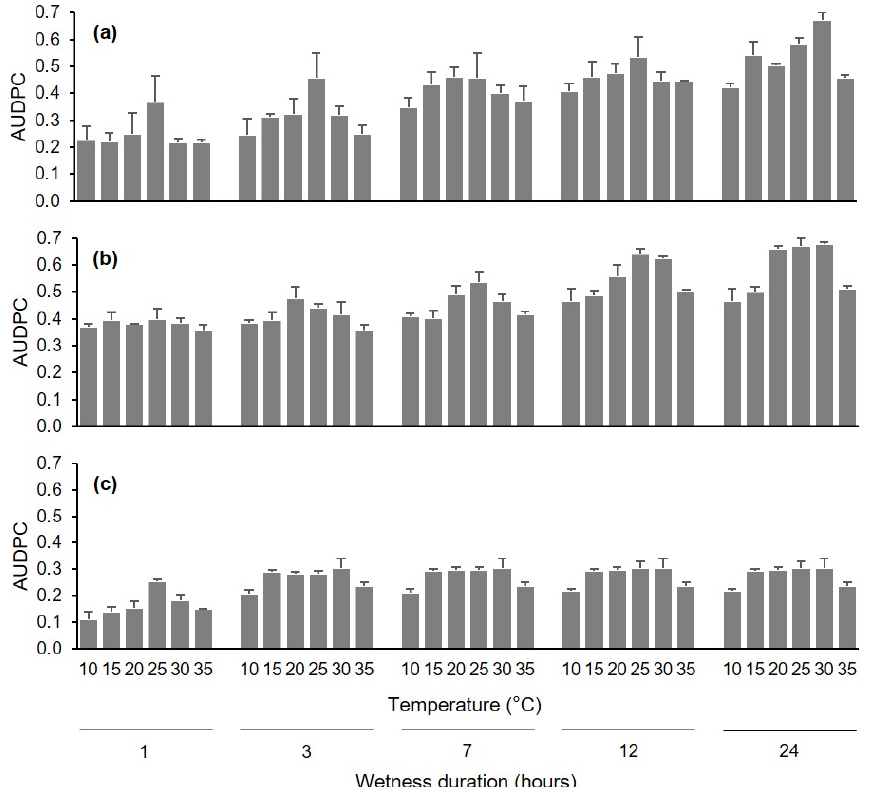
Figure 2. Values of the area under the disease progress curve (AUDPC, dimensionless) for grapevine berries inoculated with conidia of Coniella diplodiella (experiment 1). After uninjured berries ( a ), injured berries ( b ), or pedicels attached to uninjured berries ( c ) were inoculated, the berries were kept at 30 combinations of 6 temperatures and 5 wetness duration periods. Values are means (± SE, n = 45) of AUDPC data. AUDPC data were standardized by dividing the original AUDPC values by the time considered for their calculation, i.e., 10, 4, and 13 d for A, B, and C, respectively. The estimated parameters for Equation (2) were Tmin = 5 °C, Tmax = 40 °C, a = 5.067